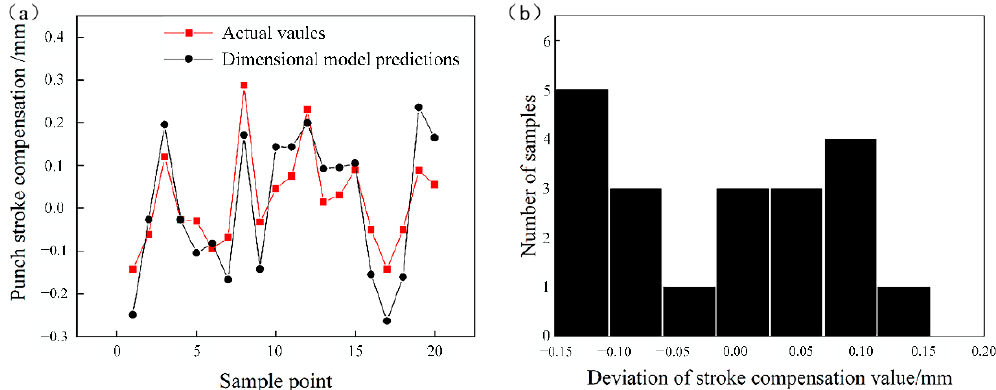
Figure 8. ( a ) Comparison of the testing samples with the predictions of the dimensional model, and ( b ) deviation of the punch stroke compensation.